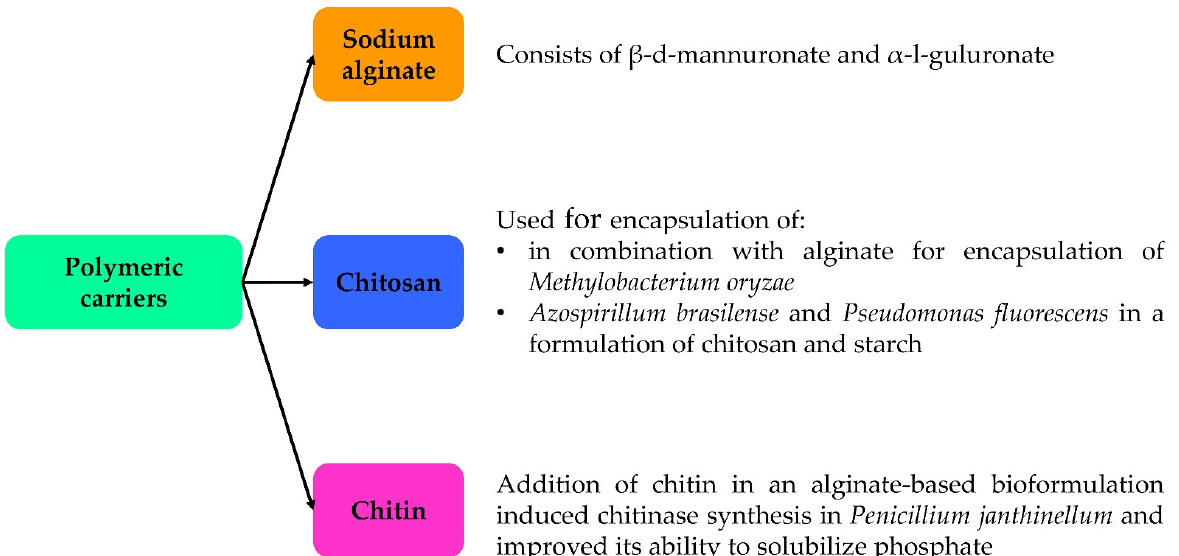
Figure 3. Polymeric carriers used in the processes of PGPM encapsulation.